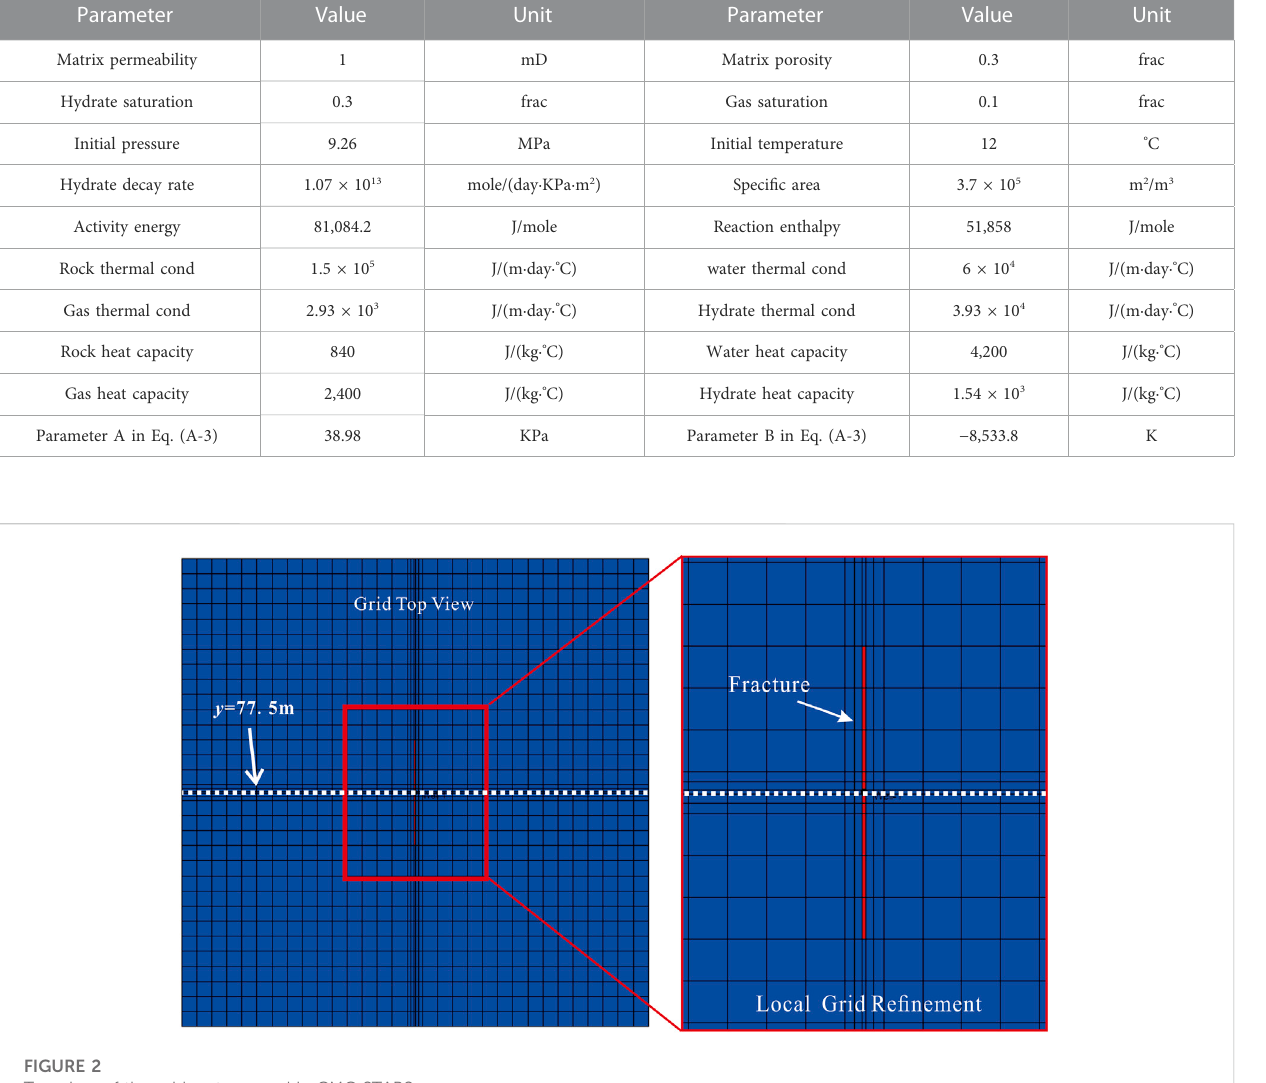
Top view of the grid system used in CMG